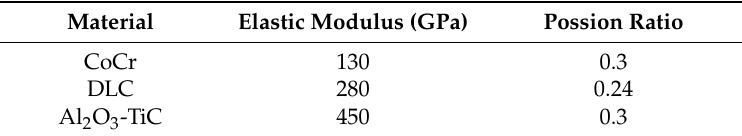
Table 1. Material parameters [5,31].